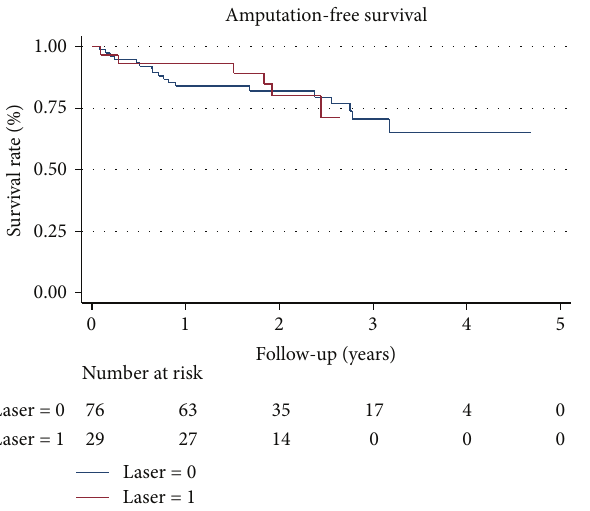
Figure 1: The Kaplan-Meier curve for amputation-free survival. Laser 1 and laser 0 mean group A and group B, respectively.